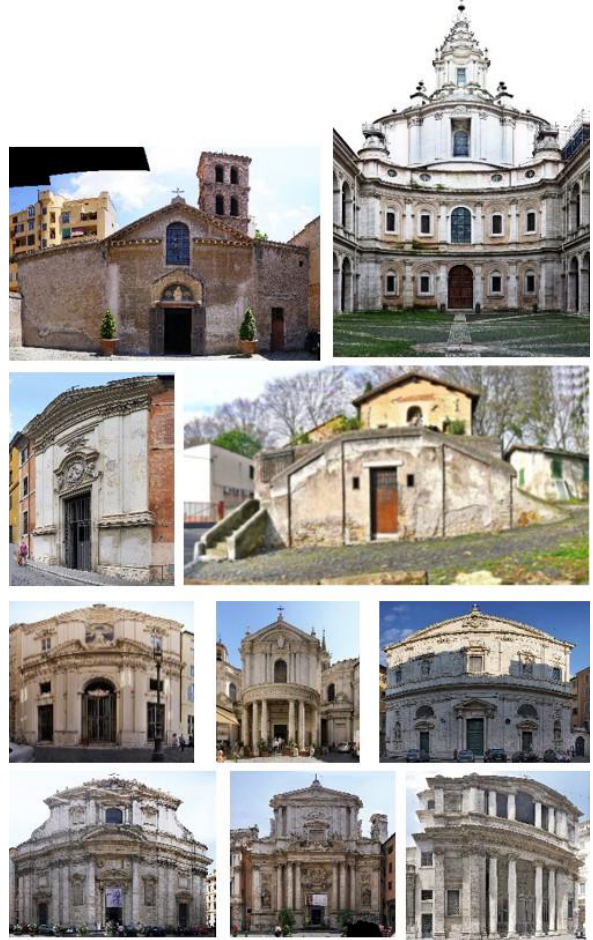
Figure 7 – Some of the facades panoramas. From left to right: in